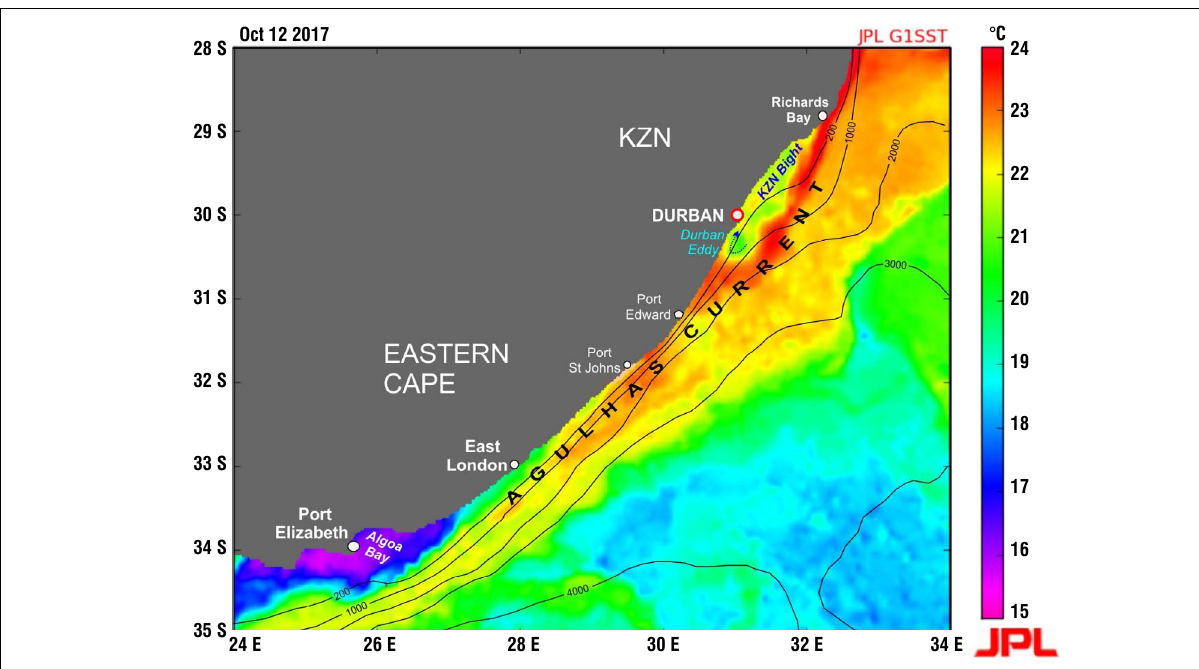
Image courtesy of the NASA Jet Propulsion Laboratory (JPL). Figure 1: The southeast coast of South Africa impacted by the nurdle release. Sites mentioned in the text are shown, with the nurdle release point at Durban circled in red. Bathymetry is given in metres while the shelf break occurs near the 200-m isobath. The warm waters of the Agulhas Current can be identified on the sea surface temperature (SST)